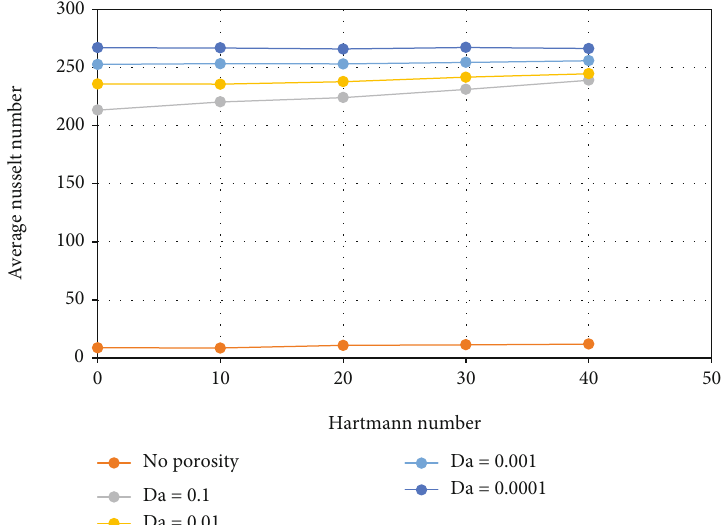
Figure 6: Average Nusselt number based on Hartmann number for di ff erent numbers of Darcy using water as the base fl uid for 0.2 nano fl